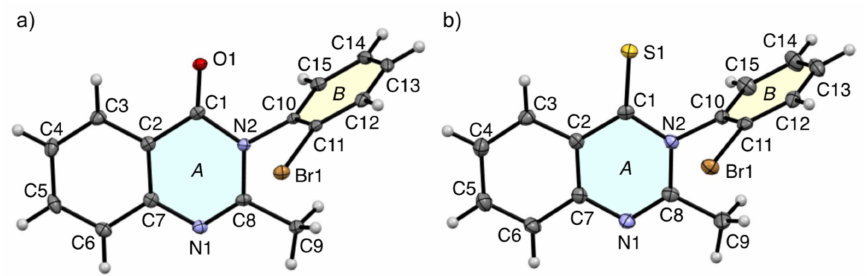
Figure 2. The molecular structures of ( a ) 1a (from CCDC1561609) and ( b ) 2a at 90 and 100 K, respectively, showing the atom-labelling schemes. Displacement ellipsoids are drawn at the 50% probability